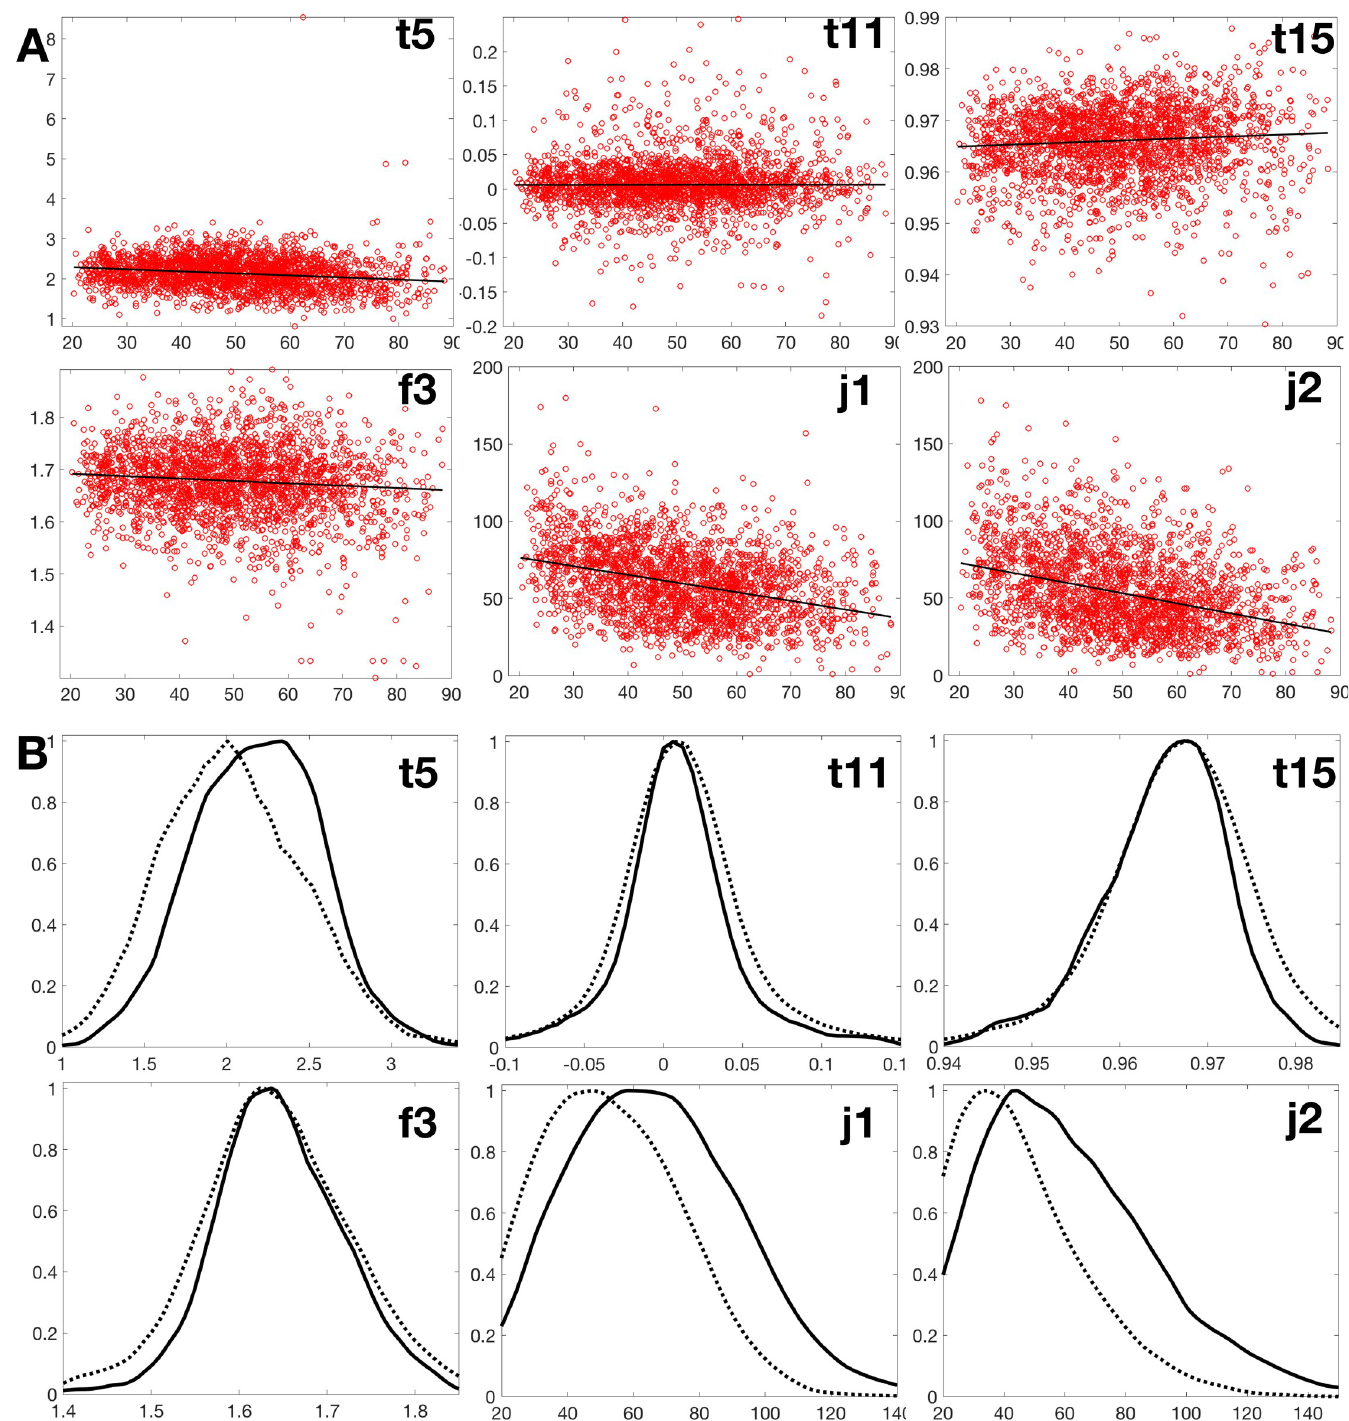
Fig 2. SardiNIA set. (A) Distribution of six selected microvascular traits according to participants’ age. The ordinates are, for t5, total square curvature; j1 and j2, numbers of terminal points and bifurcations; t11, t15, and f3, dimensionless ratios. (B) Histograms of the same six traits, with numbers of individuals as ordinate and the y-axis measures of panel A on the abscissa (solid: < 50 y.o., dashed: > 50 y.o.).